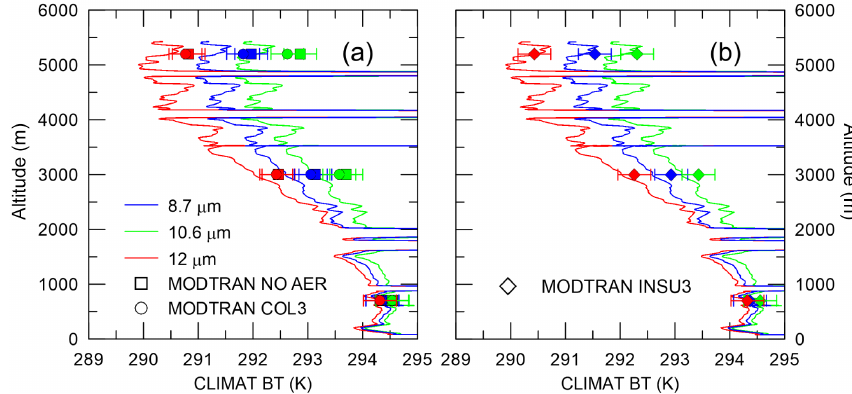
Figure 9. Same as Fig. 7, but for profile F38. The simulations are made for in situ PSD and Tunisian dust RI in (b) .